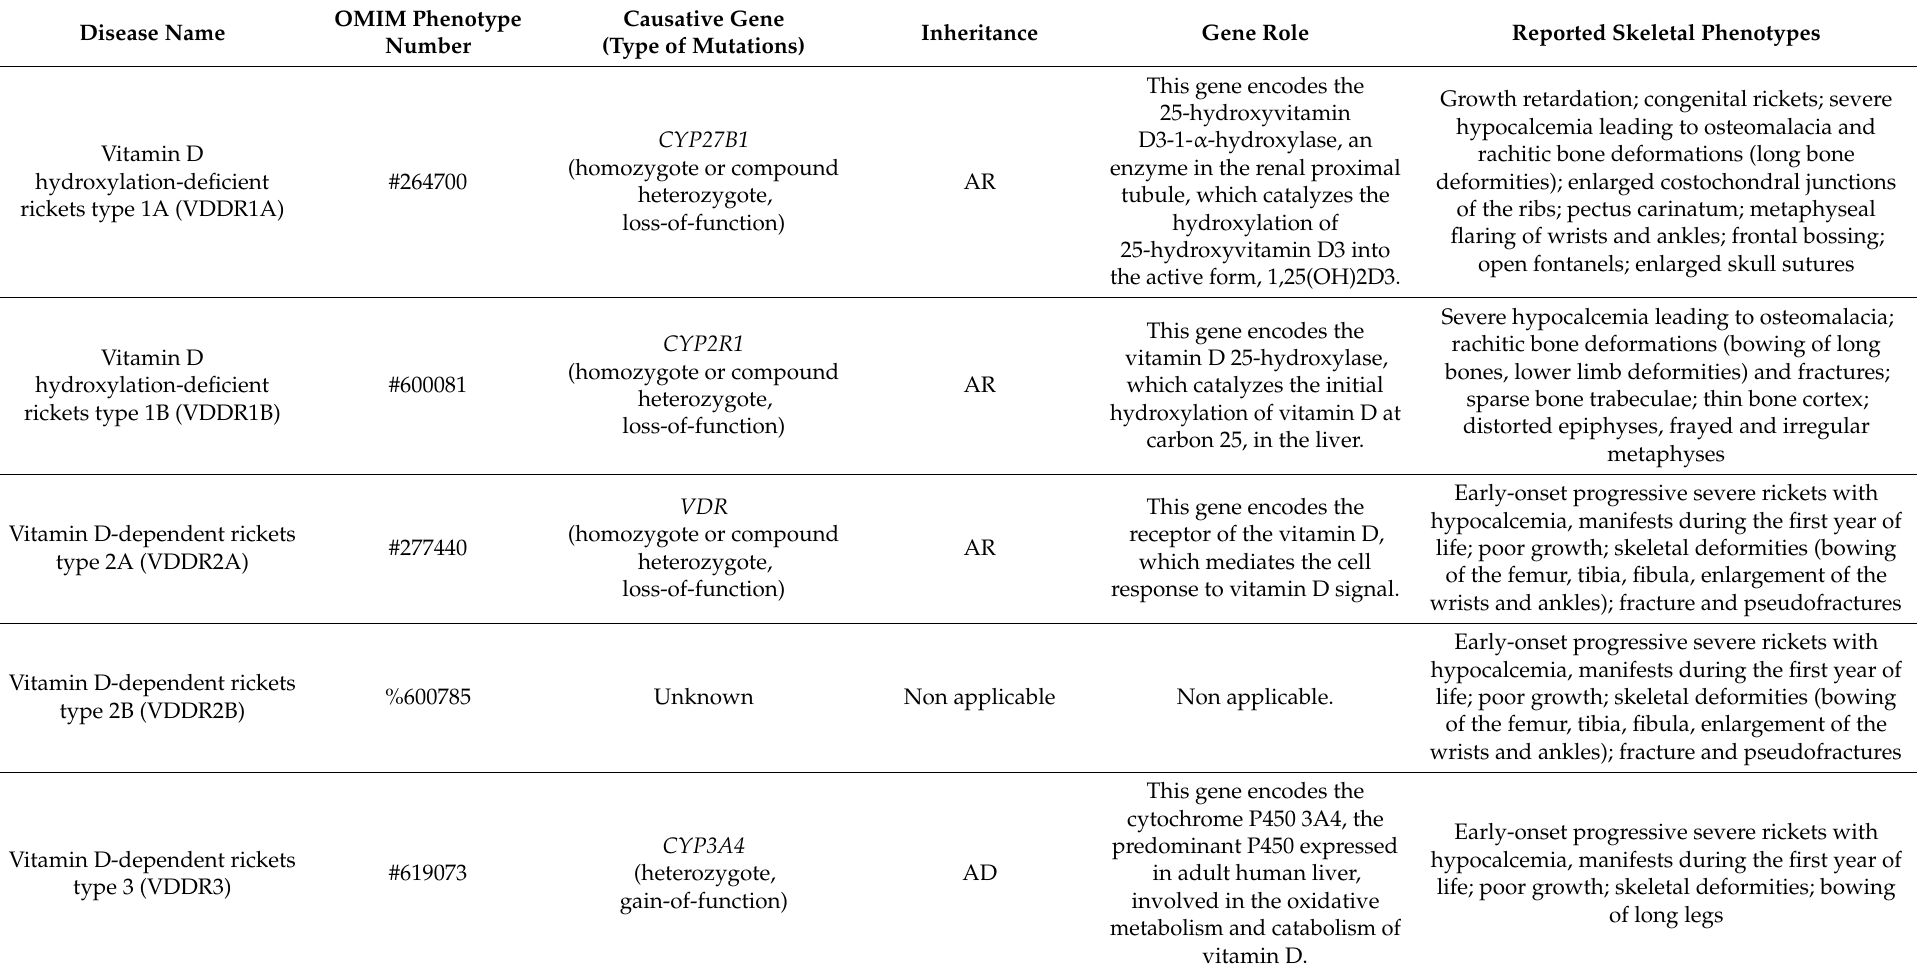
Table 4. Congenital metabolic bone disorders due to alterations of vitamin D metabolism and